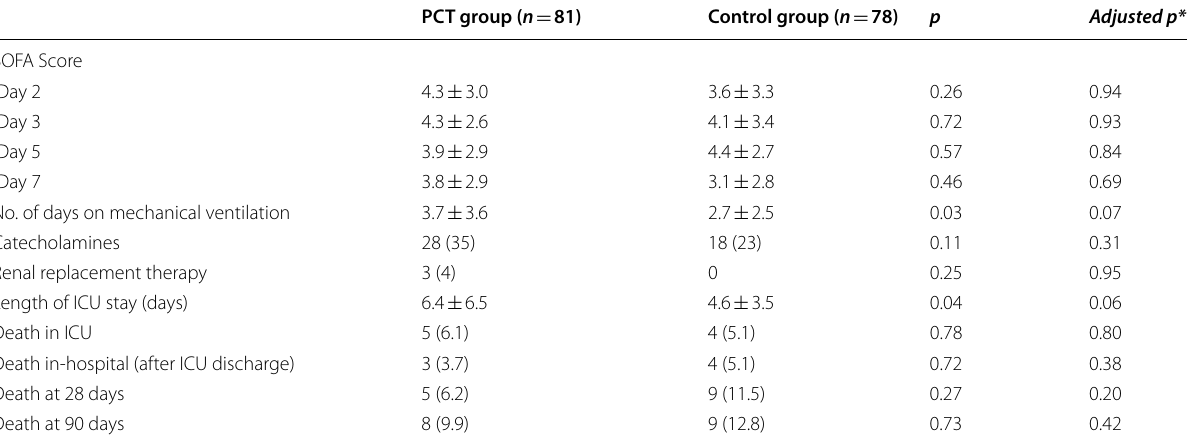
SOFA Sequential Organ Failure Assessment, ICU intensive care unit * Adjusted for SAPS II